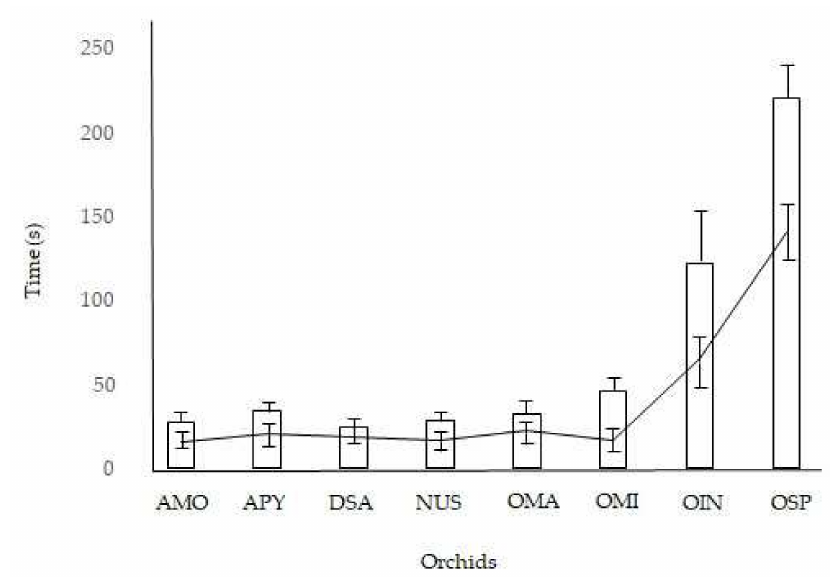
Figure 5. Pollinator residency time (black line) and reconfiguration time of pollinaria stored at 50 ◦ C (white bars) of examined orchids. AMO = Anacamptis morio , APY = A. pyramidalis , DSA = Dactylorhiza sambucina , NUS = Neotinea ustulata , OMA = Orchis mascula , OMI = Orchis militaris, OIN = Ophrys insec- tifera , OSP = O. sphegodes